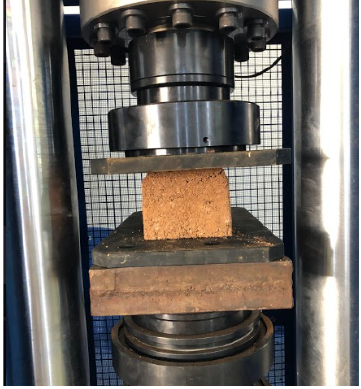
Figure 5. Compressive strength